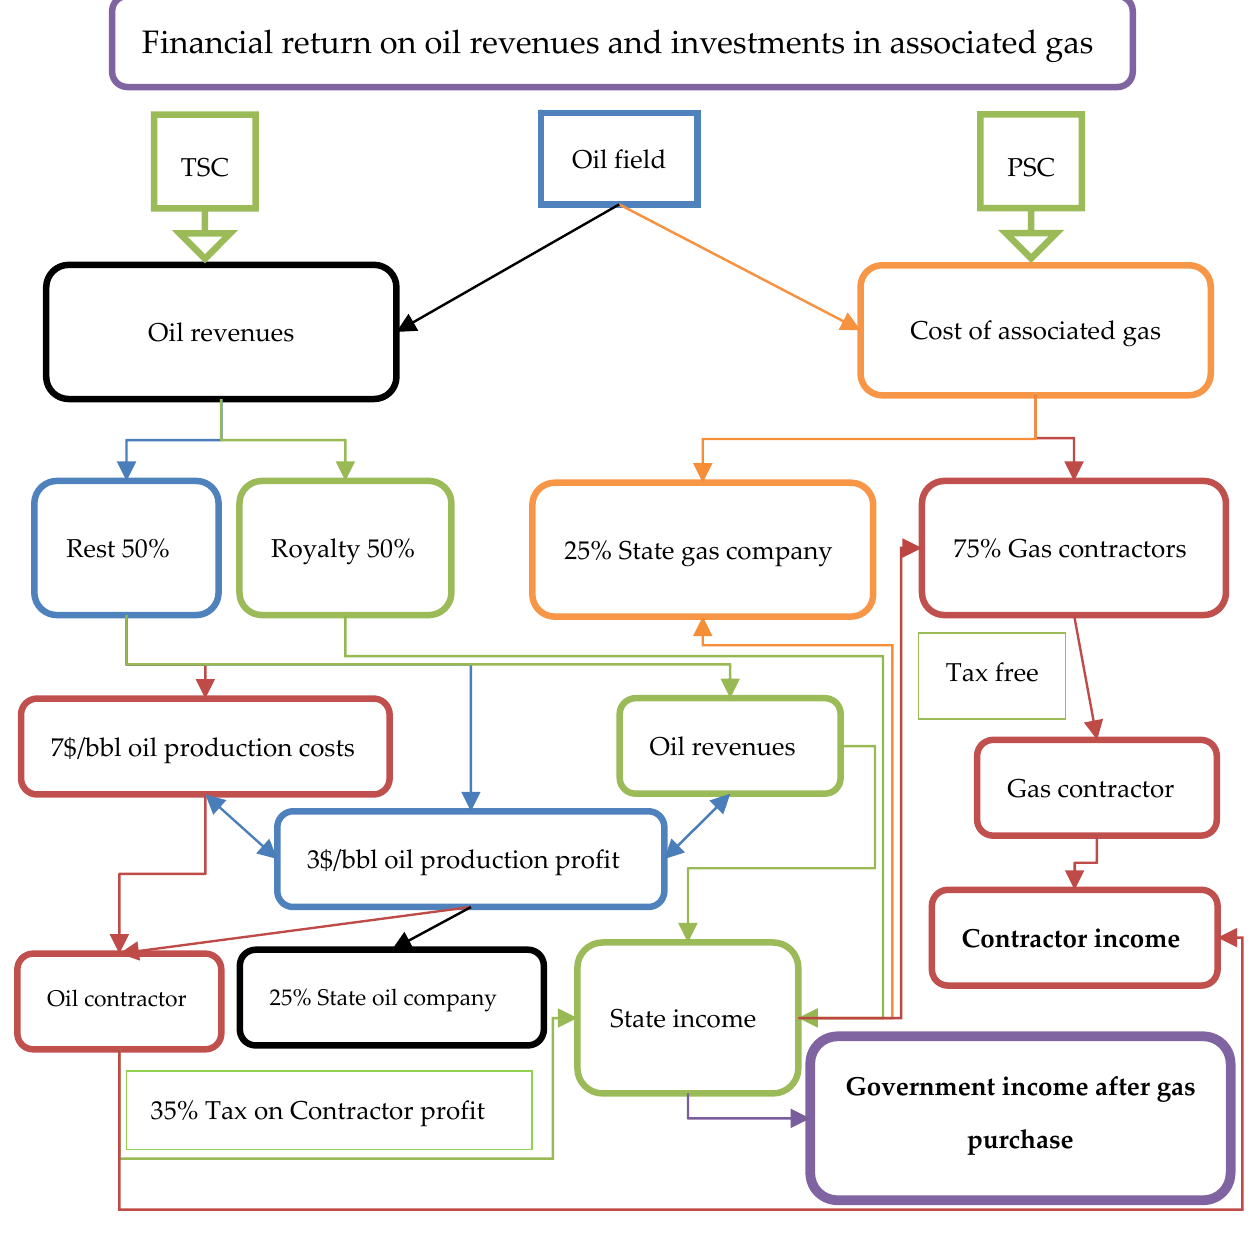
Figure 3. Diagram of financial transactions when investing in associated gas.